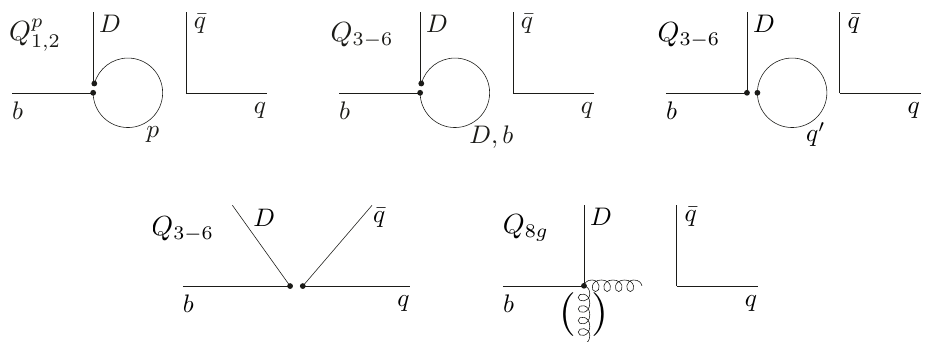
Figure 3 . Graphical illustration of the various operator insertions. The symbols stand for p 2 f u; c g , D 2 f d; s g , q 2 f u; d; s g and q 2 f u; d; s; c; b g . The black dots denote the operator 0